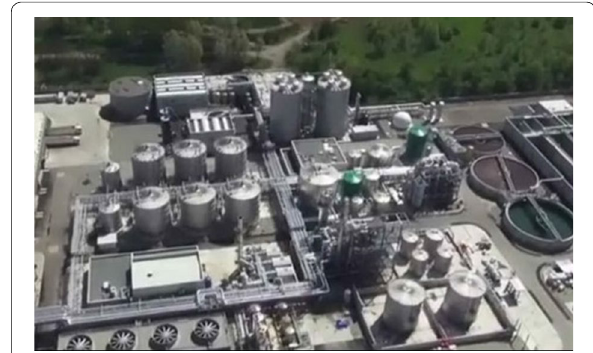
Fig. 7 Plant for bioethanol production in Crescentino (VC) (Source: Unione Sarda.it)